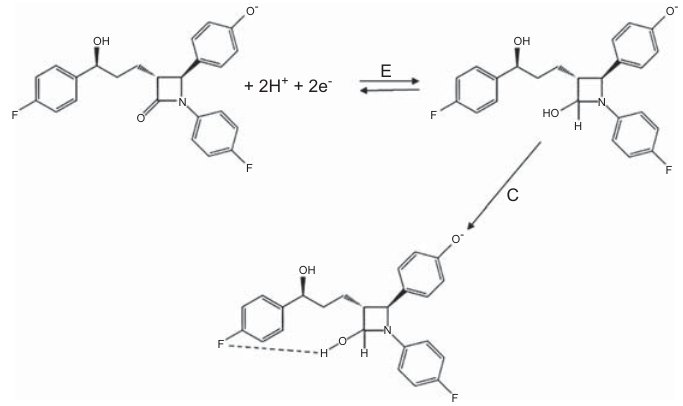
Figure 4 Reduction mechanism of EZE.